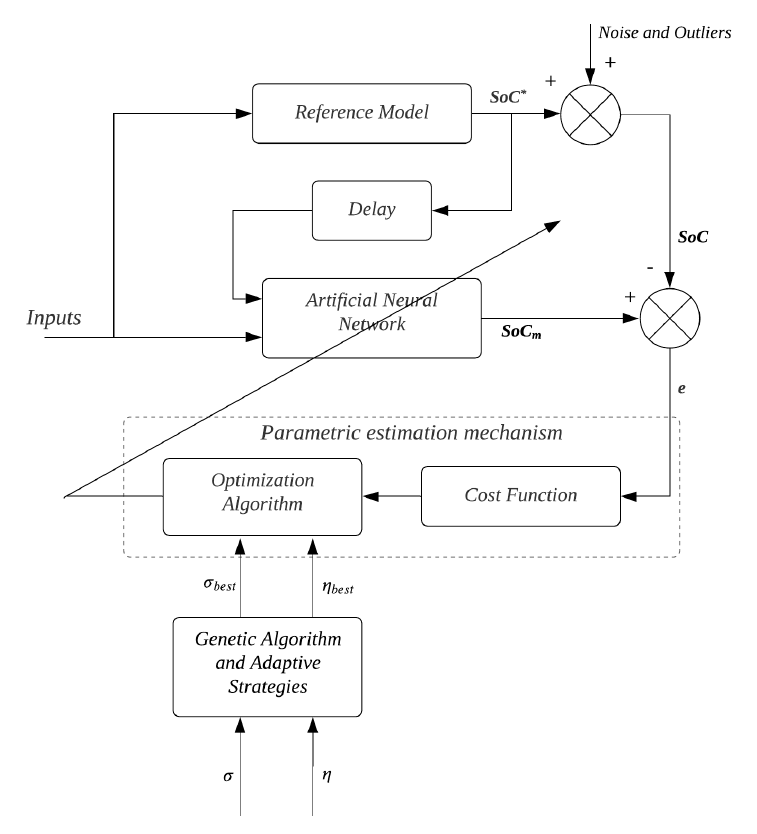
Figure 3. Diagram of the identification